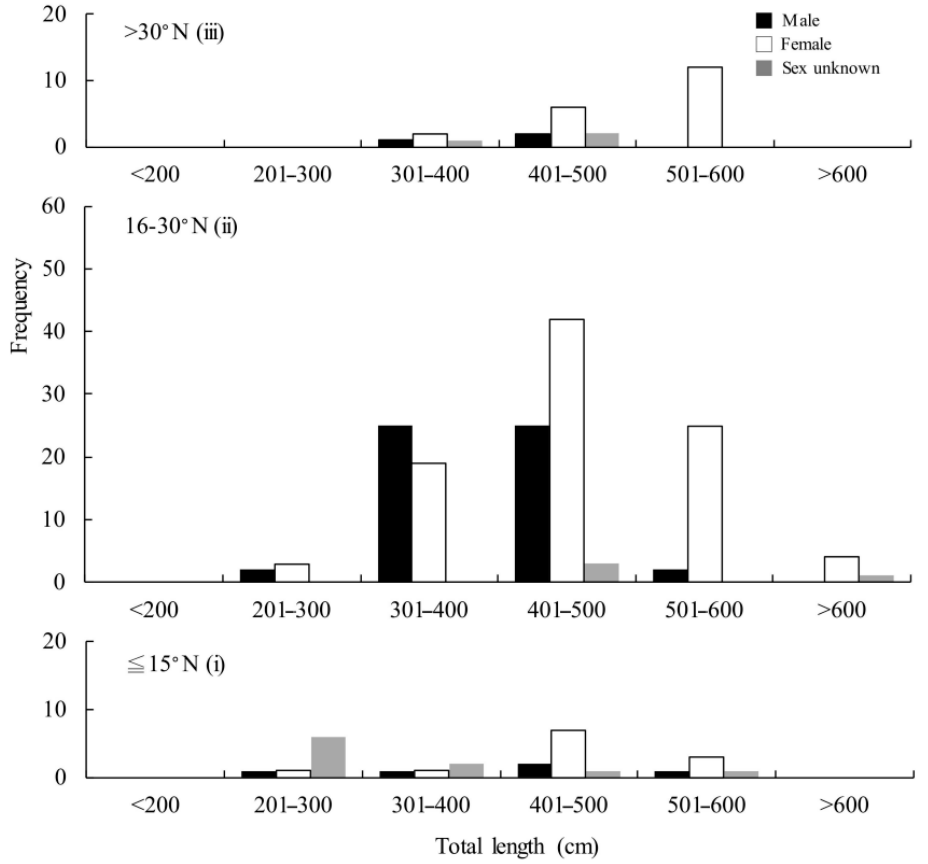
Figure 4. The length frequency of M. pelagios in the western Pacific Ocean.